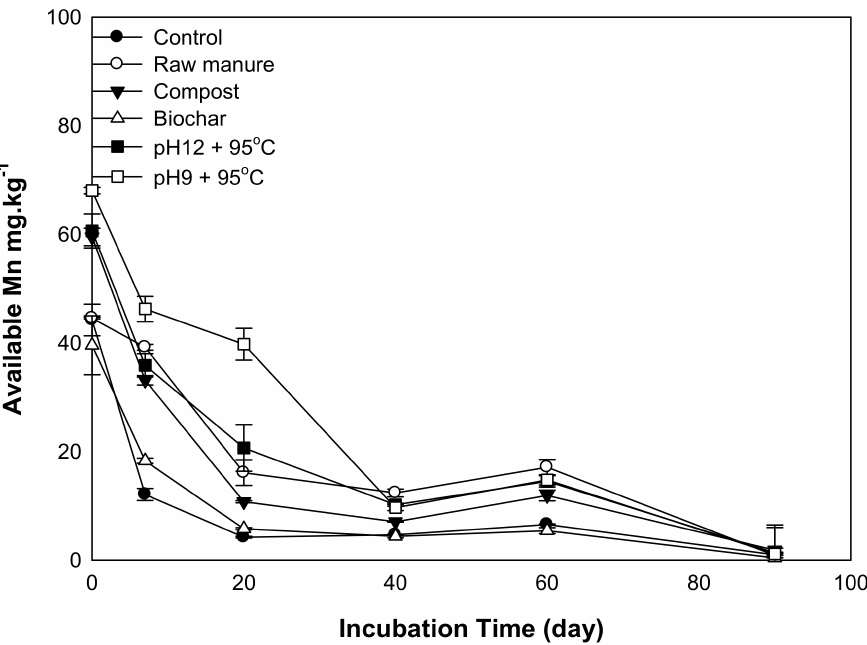
Figure 7. Soil available Mn affected by different organic amendments derived from cow manure at different incubation